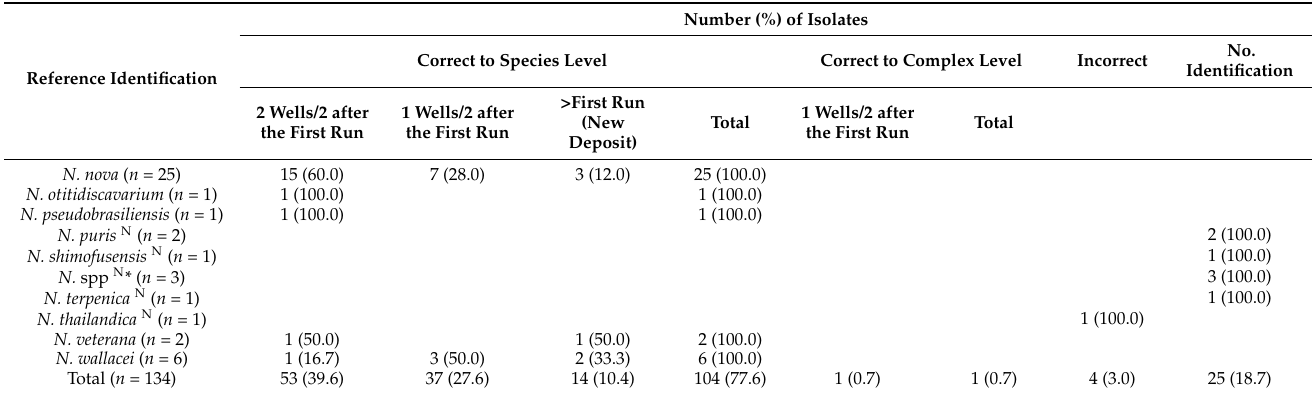
Table 1. Accuracy of Nocardia identification between VITEK-MS V3.2 results and identification based on 16S rRNA and hsp65 gene sequencing (reference identification).